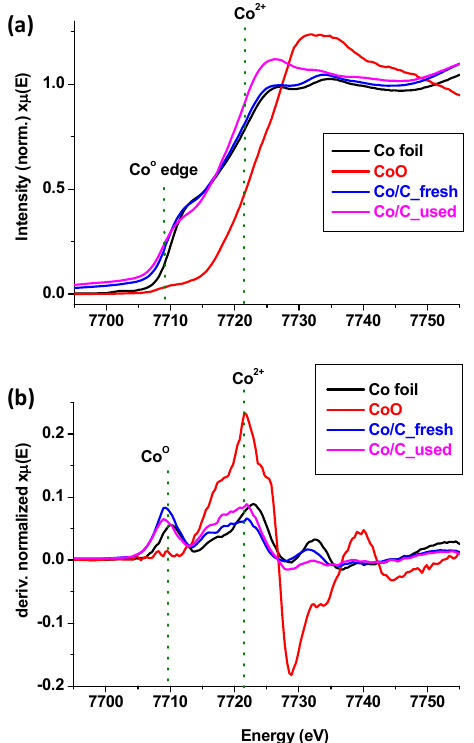
Figure 5. XANES spectra ( a ) normalized and ( b ) first derivative of the fresh and used Co/C samples compared with the Co 0 and CoO standards.